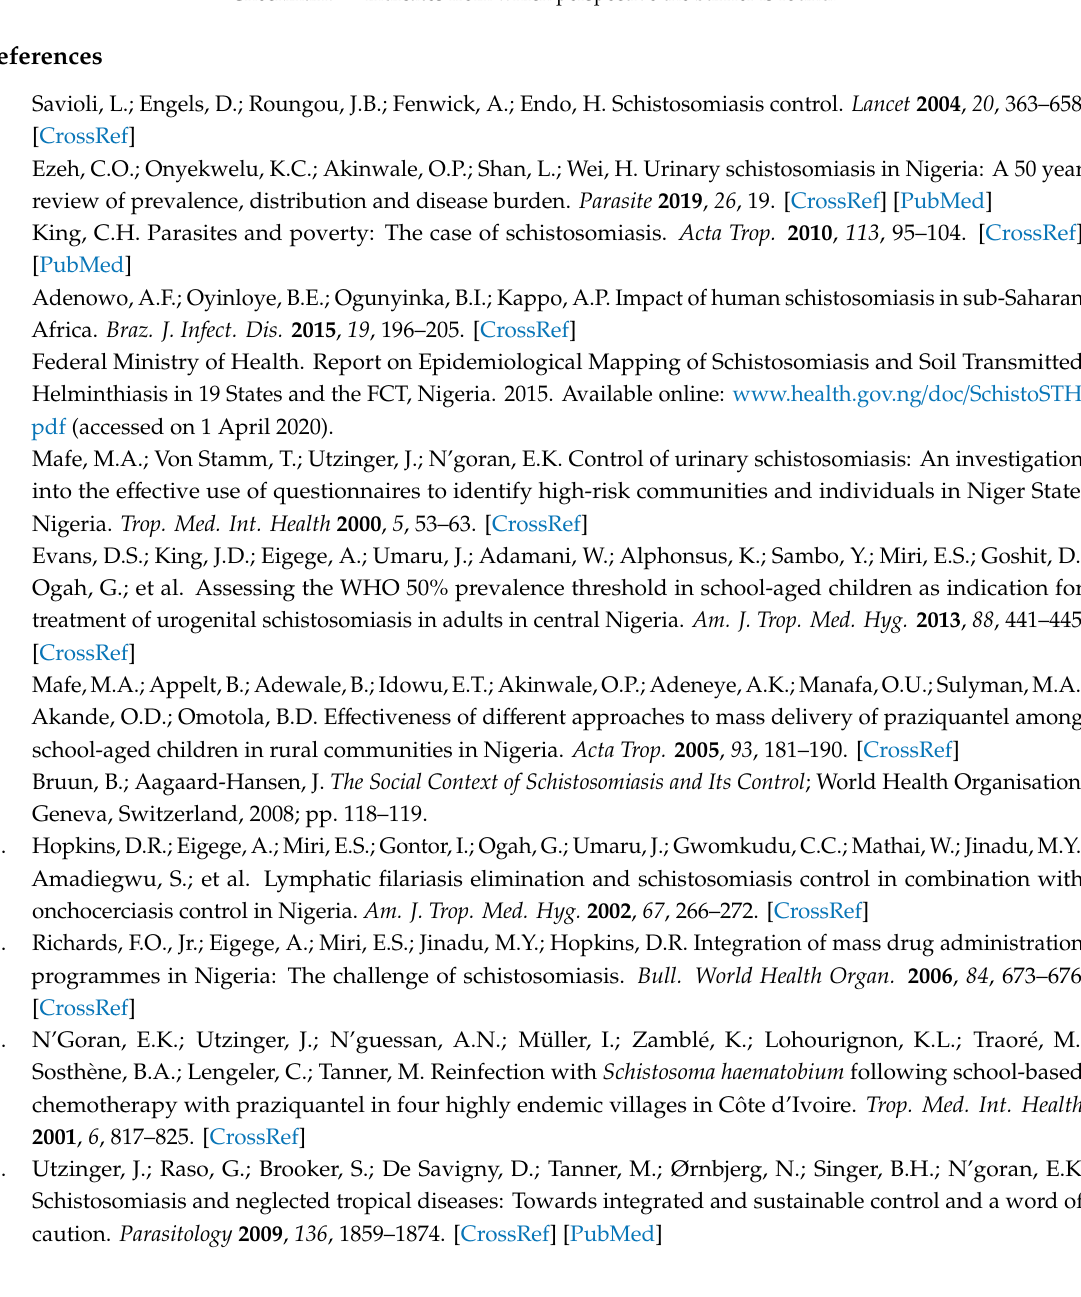
indicates from which perspective the barrier is